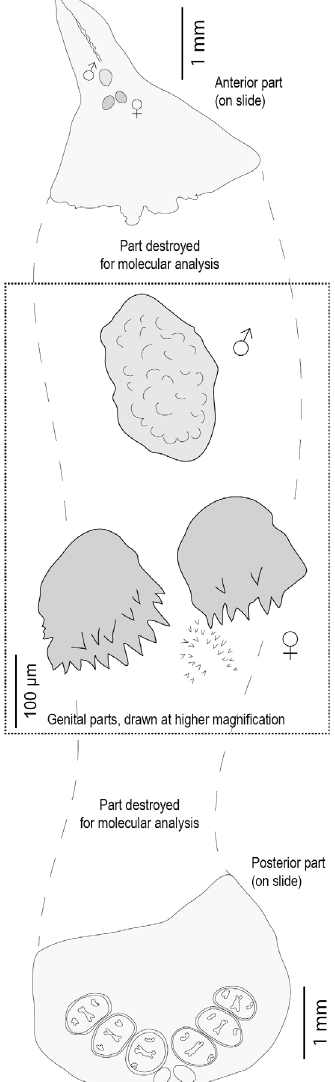
Figure 3. Specimen of Hexostoma thynni used for the molecular study. The anterior and posterior parts were mounted on a slide (MNHN HEL1757); the silhouette of the middle part, destroyed for analysis, is shown as dotted lines. The genital organs, from the anterior part, are drawn at a higher magni fi cation in the